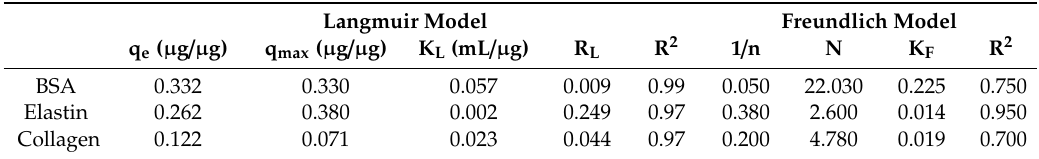
Table 2. Parameters calculated from experimental data for Langmuir and Freundlich models. Notes: q e : amount of protein adsorbed per GO weight at equilibrium; qmax: maximum amount of protein adsorbed per GO weight; K L : Langmuir constant; R L : separation factor; n: adsorption intensity; K F : Freundlich constant.